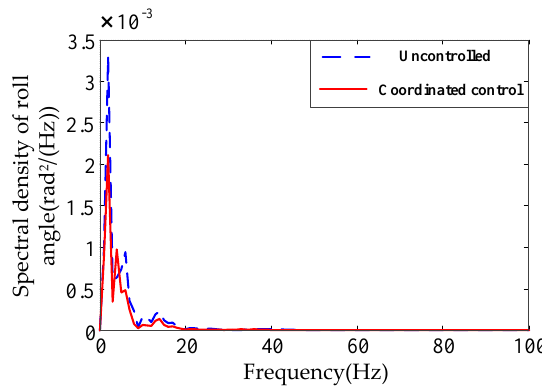
Energies 2019 , 12 , x FOR PEER REVIEW Figure 17. Response of vehicle roll angle. Figure 17. Response of vehicle roll angle. Figure 17. Response of vehicle roll angle.